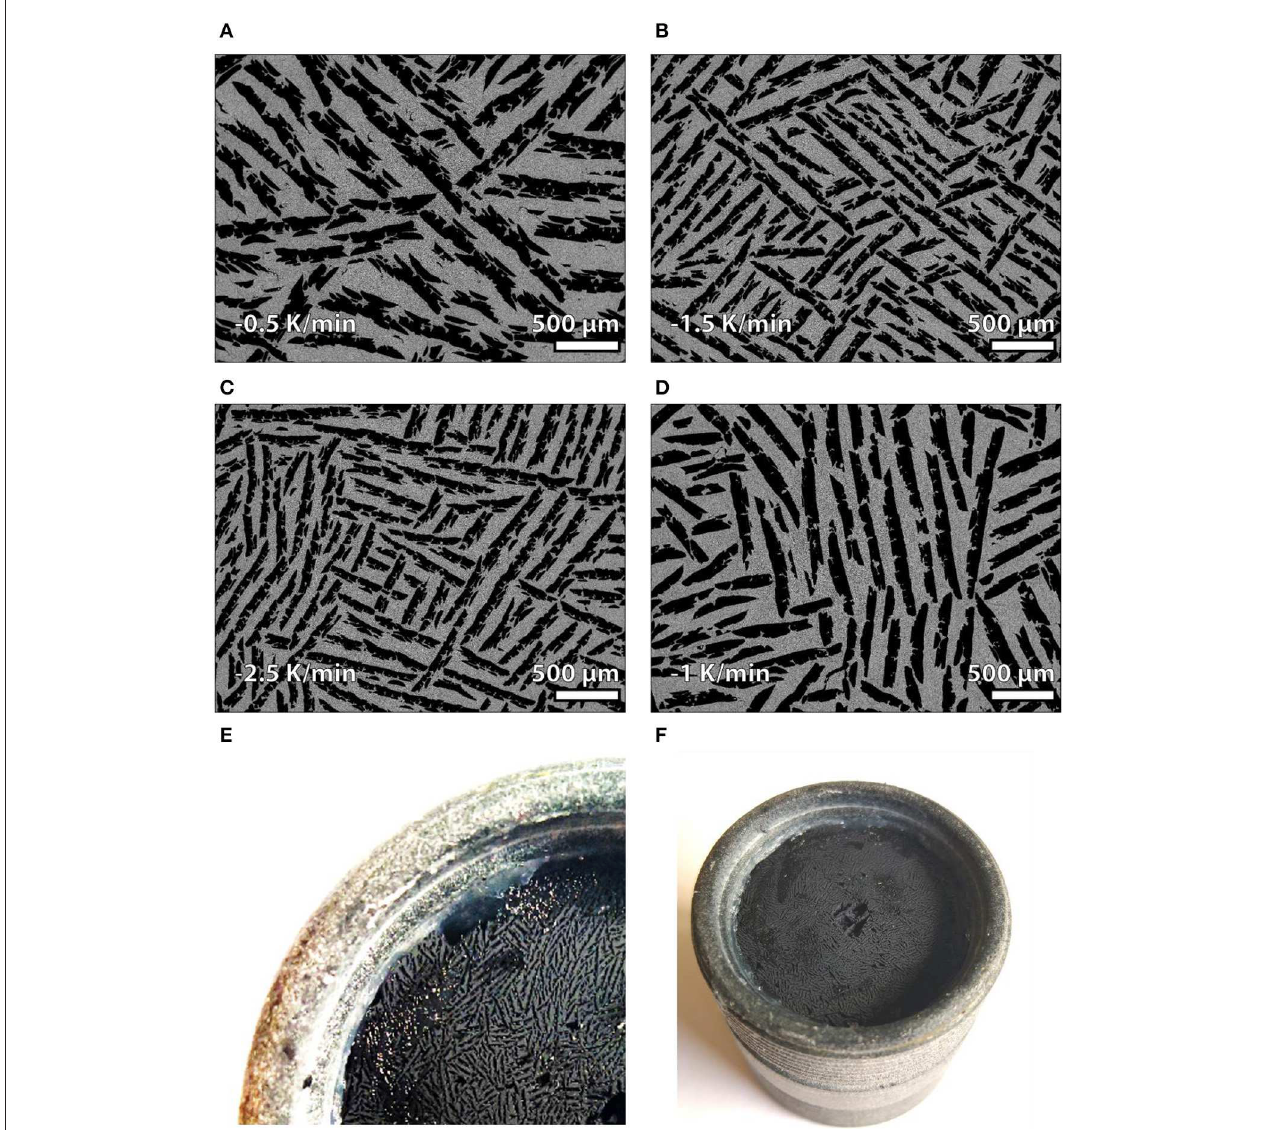
FIGURE 1 | Geometry of freeze-cast regenerators. Scanning electron microscopy (SEM) micrographs of cross sections of the freeze-cast samples from regenerators #1 (A) , #2 (B) , #3 (C) and #4 (D) , where gray areas are the ceramic walls and black areas voids in the form of aligned, lamellar channels. Micrographs were obtained at cross sections parallel to the freezing direction in the center of the structure. Photographs of regenerator #1 (E,F) after mounting the samples into the housing. A single freeze-cast regenerator matrix consists of two combined monolithic pieces of freeze-cast samples frozen at identical conditions and thus with homogenous structural characteristics. Other SEM images at different positions are available at Supplementary Presentation 1